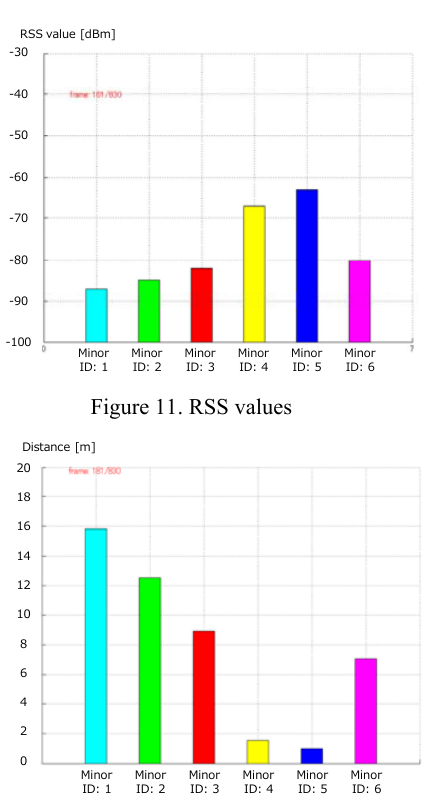
Figure 12. Estimated distances